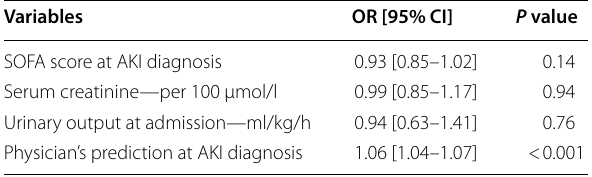
Table 2 Physician’s prediction of need of RRT at ICU admission